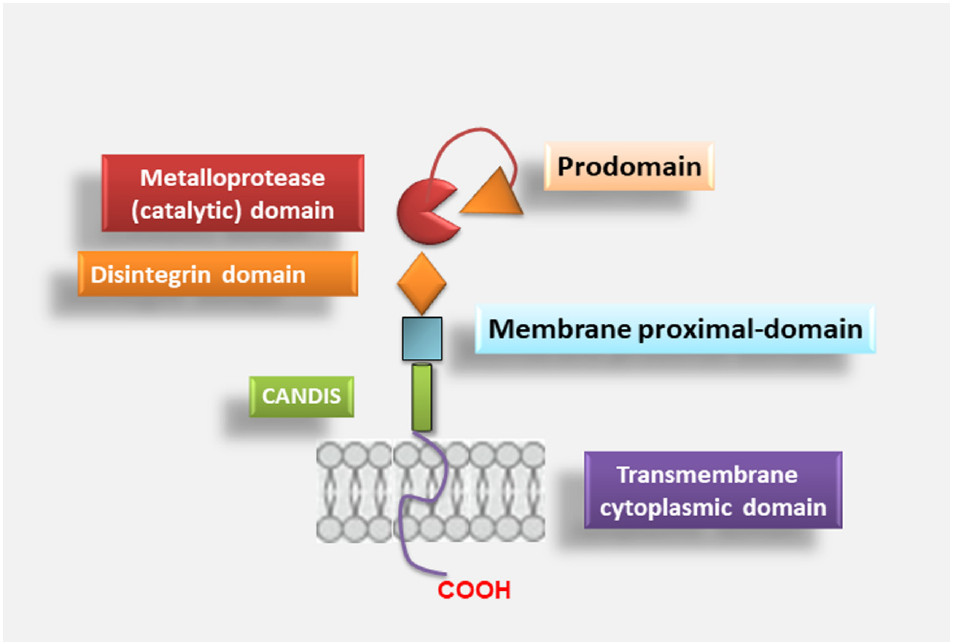
Figure 1. Overview of the ADAM17 structure. The metalloprotease ADAM17 shows six domains that include: N -terminal pro-domain followed by a metalloproteinase or catalytic domain, a disintegrin domain, a membrane-proximal domain, a Conserved ADAM-seventeeN Dynamic Interaction Sequence (CANDIS) and ends with a cytosolic tail.